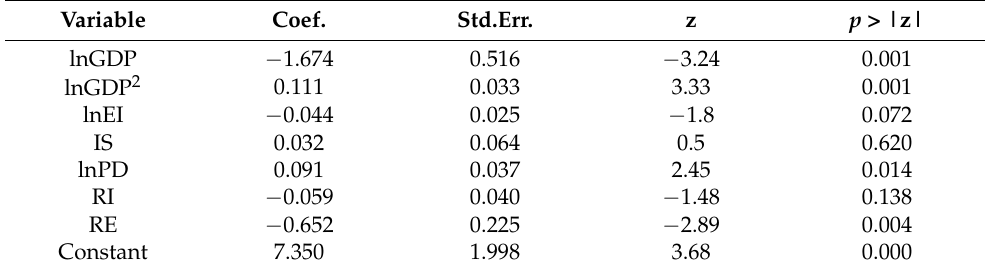
Variable for Mean Std.Dev. Regression